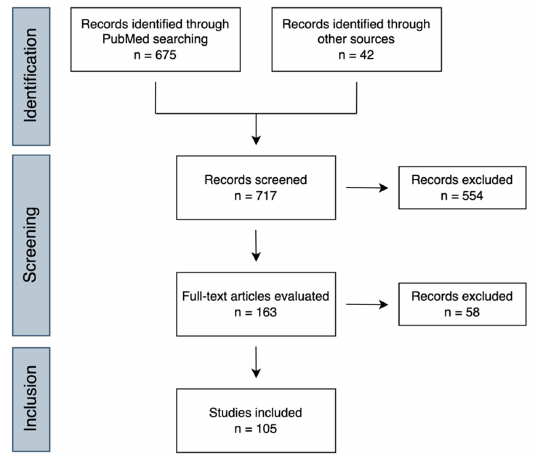
Figure 2. Flow diagram of the conducted search methodology for this review.